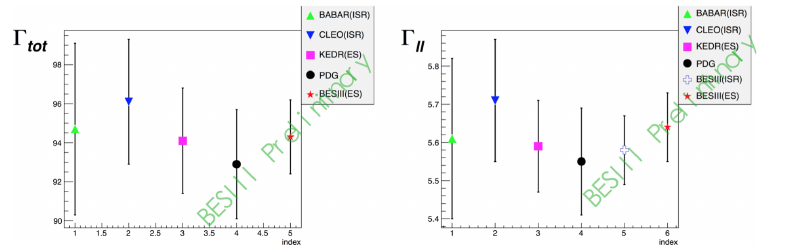
Figure 4. Comparisons of full width and lepton width of J /ψ meson for the preliminary BESIII results and other previous measurements [2].